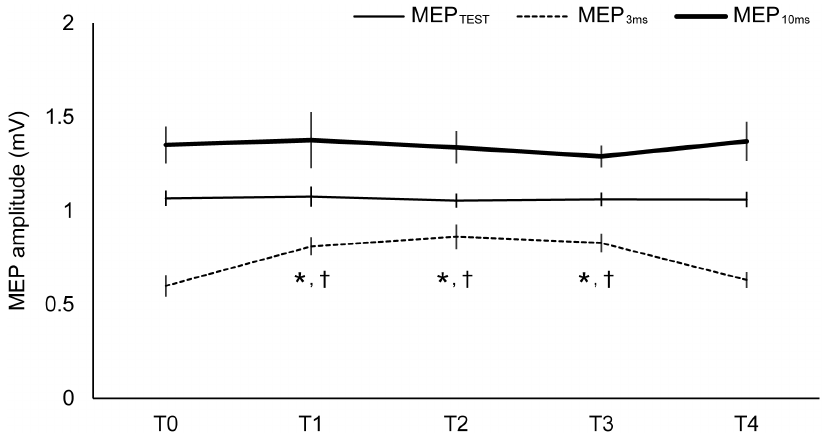
Figure 6. Changes in MEP amplitude induced by adjusted test stimulus (TS) in whole-body WF. TS intensity was adjusted to elicit an unconditioned test MEP in the relaxed right FDI of approximately 1 mV peak-to-peak amplitude in each assessment. Asterisks (*) indicate significant differences (p , 0.05) compared with T0. Daggers ( { ) indicate significant differences (p , 0.05) compared with T4.